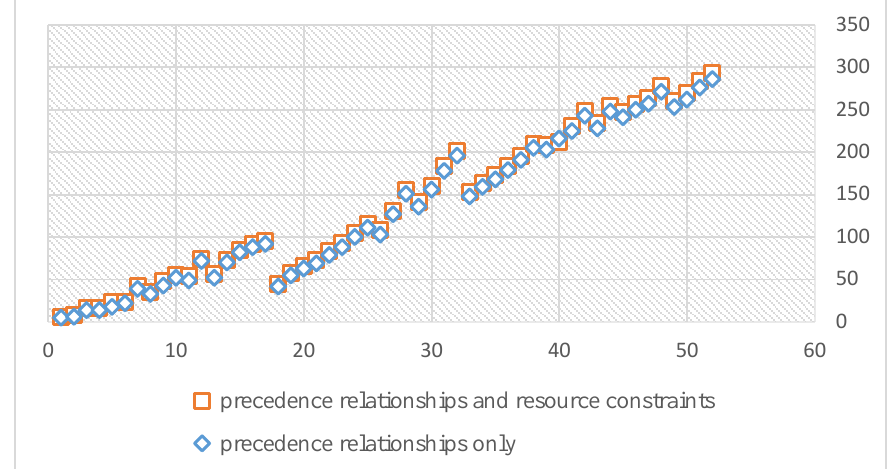
Figure 16. Optimal time duration for two considered scenarios.